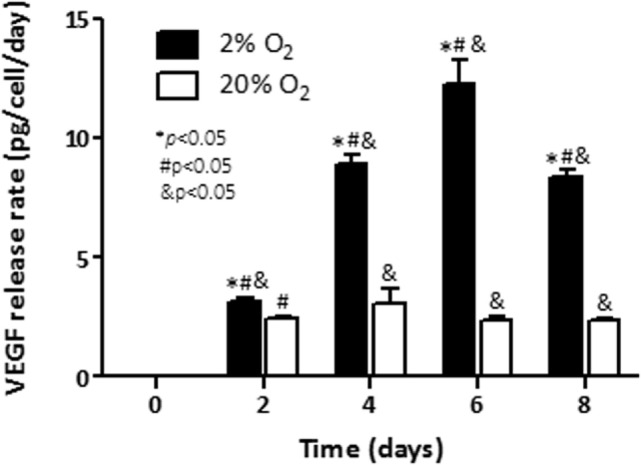
Effect of hypoxia on VEGF production: rates of vascular endothelial growth factor (VEGF) release in conditioned culture media were measured by ELISA for C4-2B cells growing under hypoxia (■) or normoxia (□). *p < 0.05 when data at 2% O2 are compared to values at 20% O2 at the same time point; #p < 0.05 when data at 2% O2 or 20% O2 are compared to a previous time point within the same O2%; and &p < 0.05 when a specific data point is compared to the point at day 0 within the same O2%.